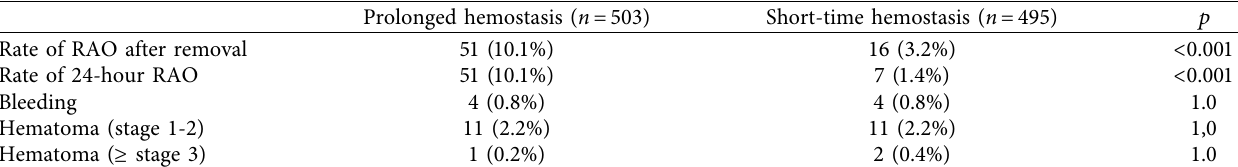
Table 3: Frequency of